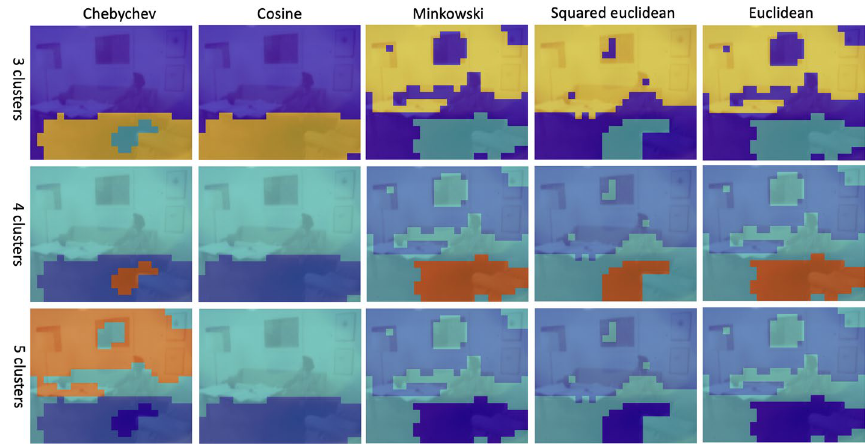
Fig. 6 Segmentation results with different distance metrics, using a grid size of 50 agglomeration method